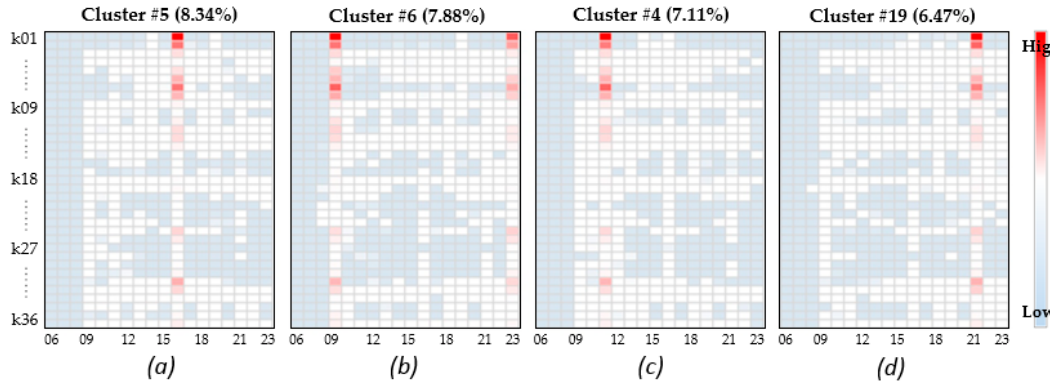
Figure 12. Examples of the mobility patterns on the holiday. ( a ) mobility pattern of cluster 5; ( b ) mobility pattern of cluster 6; ( c ) mobility pattern of cluster 4; and ( d ) mobility pattern of cluster 19. Note: (1) k1 = C-C, k2 = C-H, k3 = C-P, k4 = C-R, k5 = C-T, k6 = C-W, k7 = H-C, k8 = H-H, k9 = H-P, k10